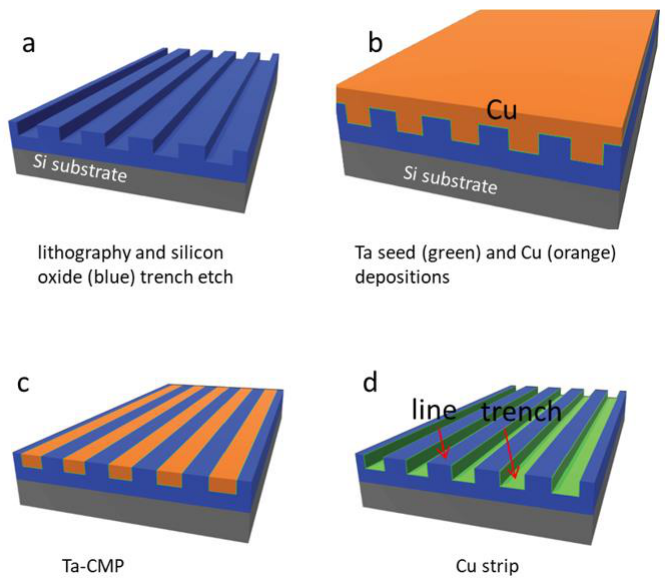
Figure 1. Schematic illustration of processing flow for tantalum (Ta) polished specimens. Parallel line/trench patterns were transferred to the silicon oxide thin film (blue) by lithography and dry